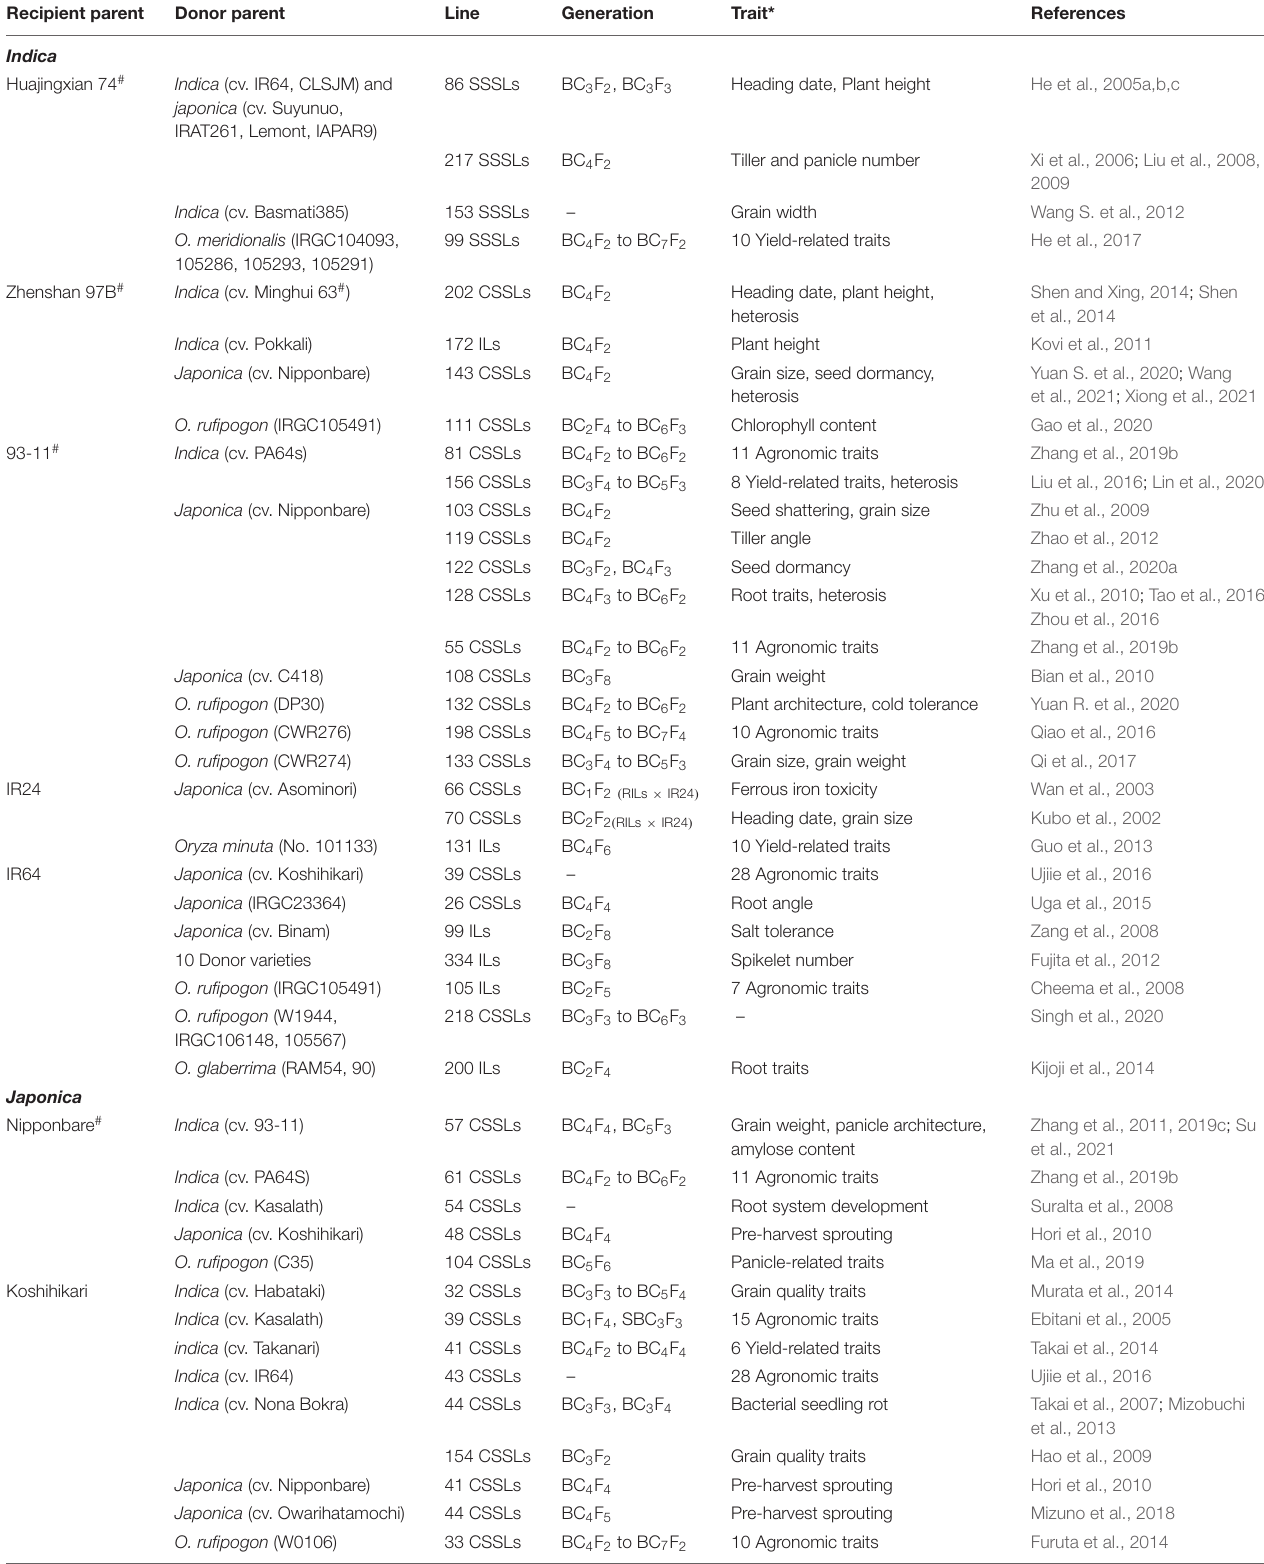
TABLE 1 | List of introgression lines developed with several elite cultivars as recipient parents. Recipient